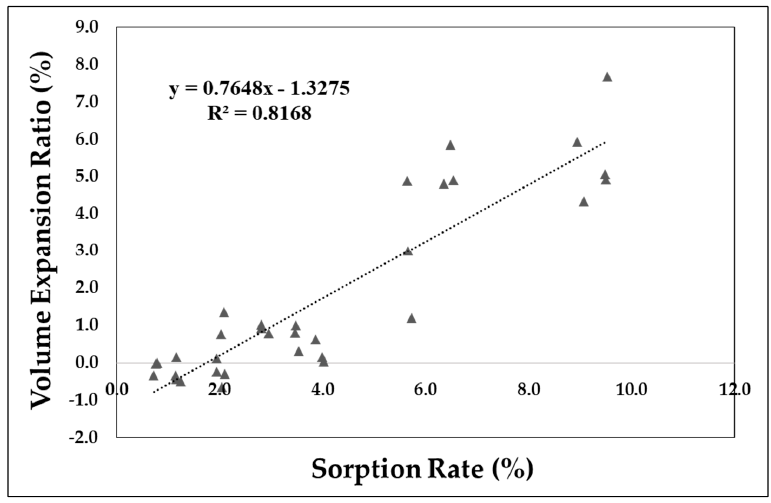
Figure 10. Relationship between adsorption rate and volume expansion ratio.